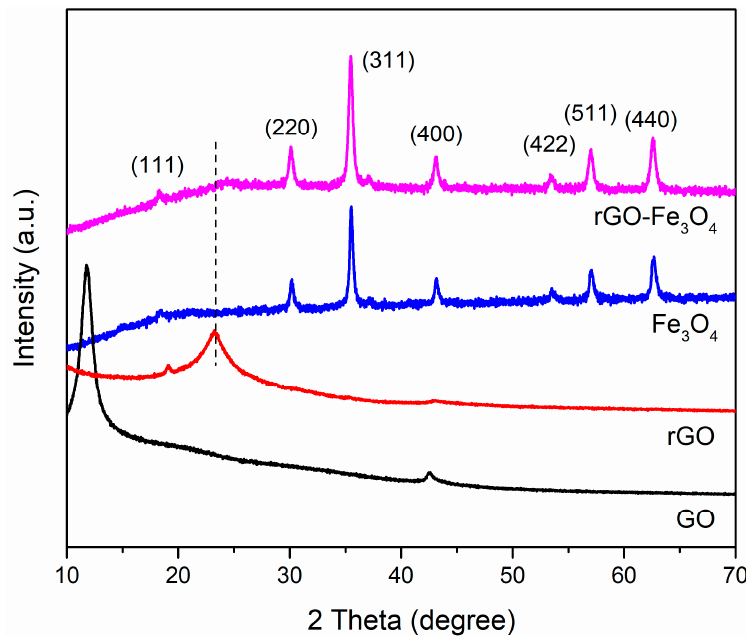
ff raction patterns of GO, rGO, Fe Figure 1. X-ray diffraction patterns of GO, rGO, Fe 3 O 4 , and rGO–Fe 3 O 4 nanocomposites. Figure 1. X-ray di